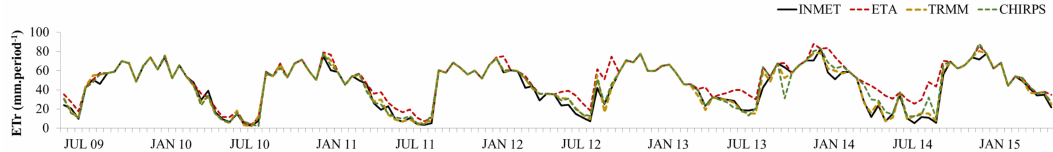
Figure 7. Average values of evapotranspiration (ETR) estimated through the sequential water balance, using INMET, Eta, TRMM, and CHIRPS data, for the period July 2009 to June